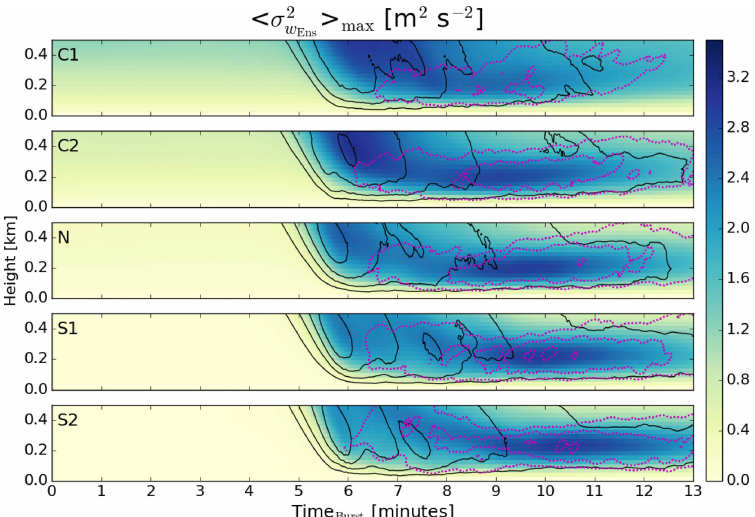
Figure 12. The same as Fig. 8 but for vertical velocity variance.